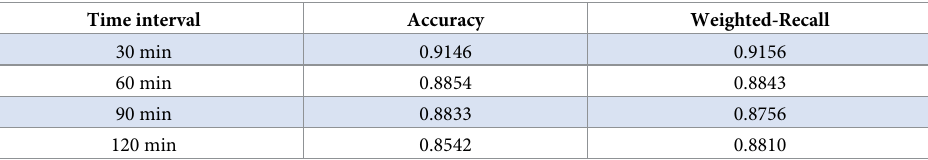
Table 7. Prediction performance for different time